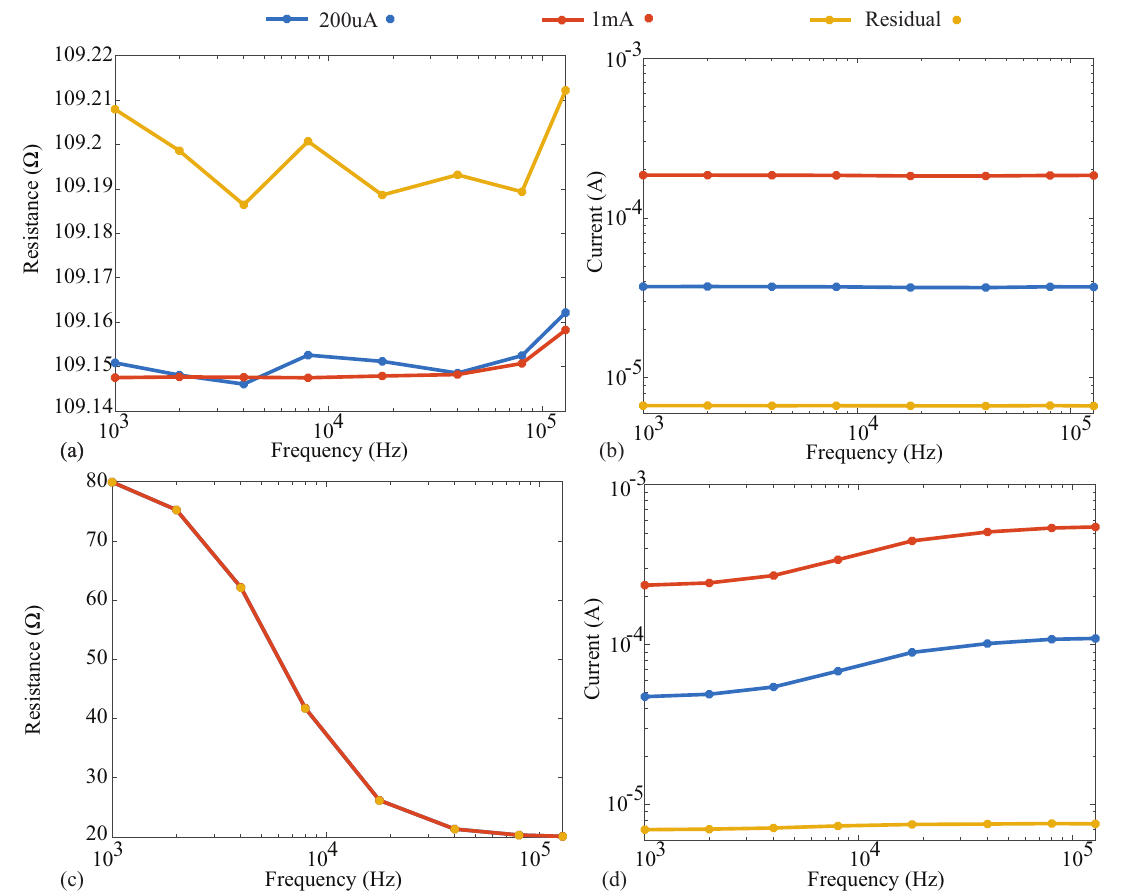
Figure A2. ( a ) Reported resistance and ( b ) injection current during measurement of a 110 Ω resistor when the Keysight E4990A was configured for 1 mA, 200 µA, and approximately 8 µA (using a current-limiting resistor); ( c ) reported resistance and ( d ) injection current during measurement of the 2 R − 1 C Model 1 when the Keysight E4990A was configured for 1 mA, 200 µA, and approximately 8 µA (using a current-limiting resistor).